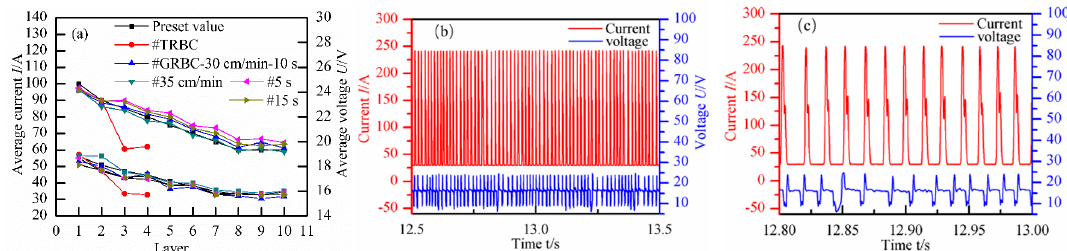
Figure 3. Current and voltage waveforms of additively manufactured walls: ( a ) Comparison of average currents and voltages for different samples and preset values; ( b ) partial current and voltage waveforms of the 7th layer of sample #GRBC-30 cm/min-10 s; ( c ) enlarged current and voltage waveforms from 12.8 to 13 s in ( b ). (TRBC and GRBC represent transient and gradual reduction of bottom current, respectively).